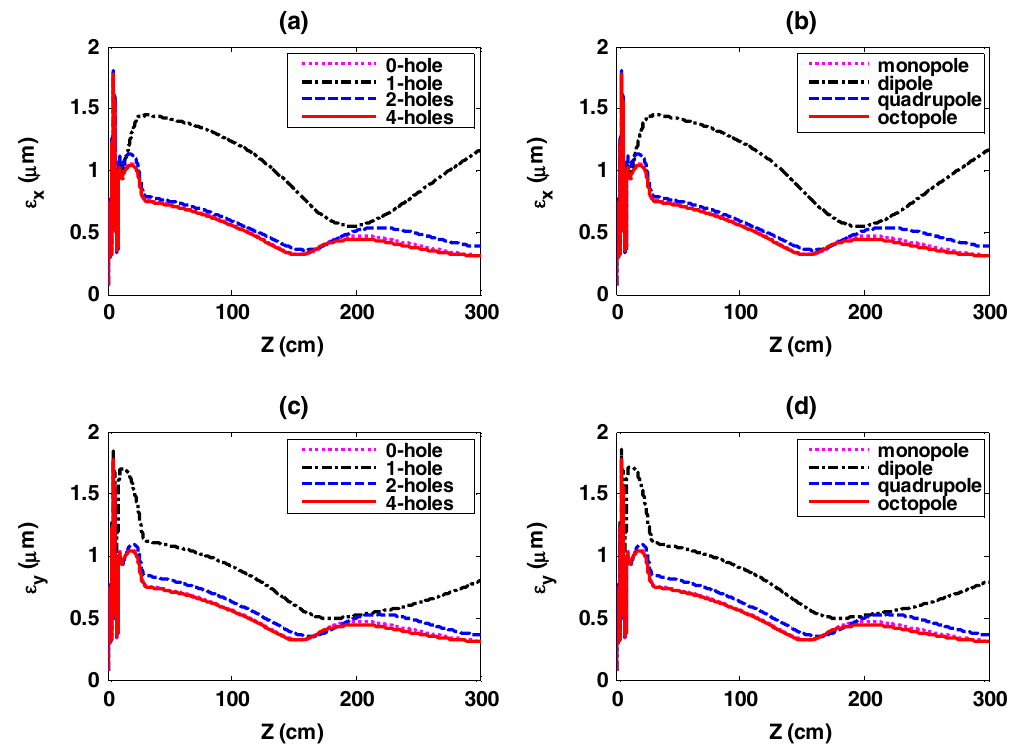
FIG. 9. Simulation results of rms emittance in both directions without solenoid field for the beam charge of 0.1 nC. (a) Emittance evolutions in the horizontal ( x ) direction for each model. (b) Emittance evolutions from the dominant multipole field from each model in the horizontal ( x ) direction. (c) Emittance evolutions in the vertical ( y ) direction for each model. (d) Emittance evolutions from the dominant multipole field from each model in the vertical ( y )